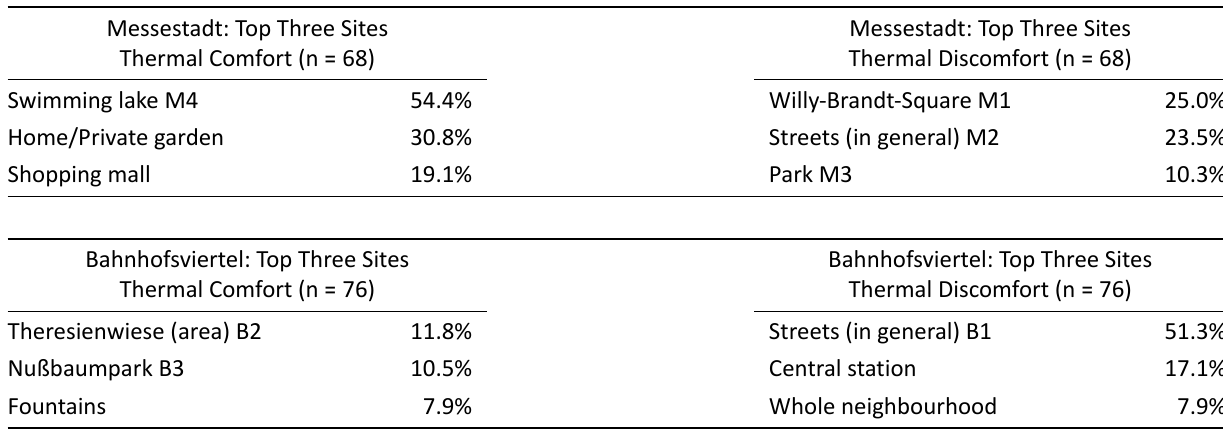
Table 1. Top three comfortable (left) and uncomfortable (right) sites in hot weather in each neighbourhood. Messestadt: Top Three